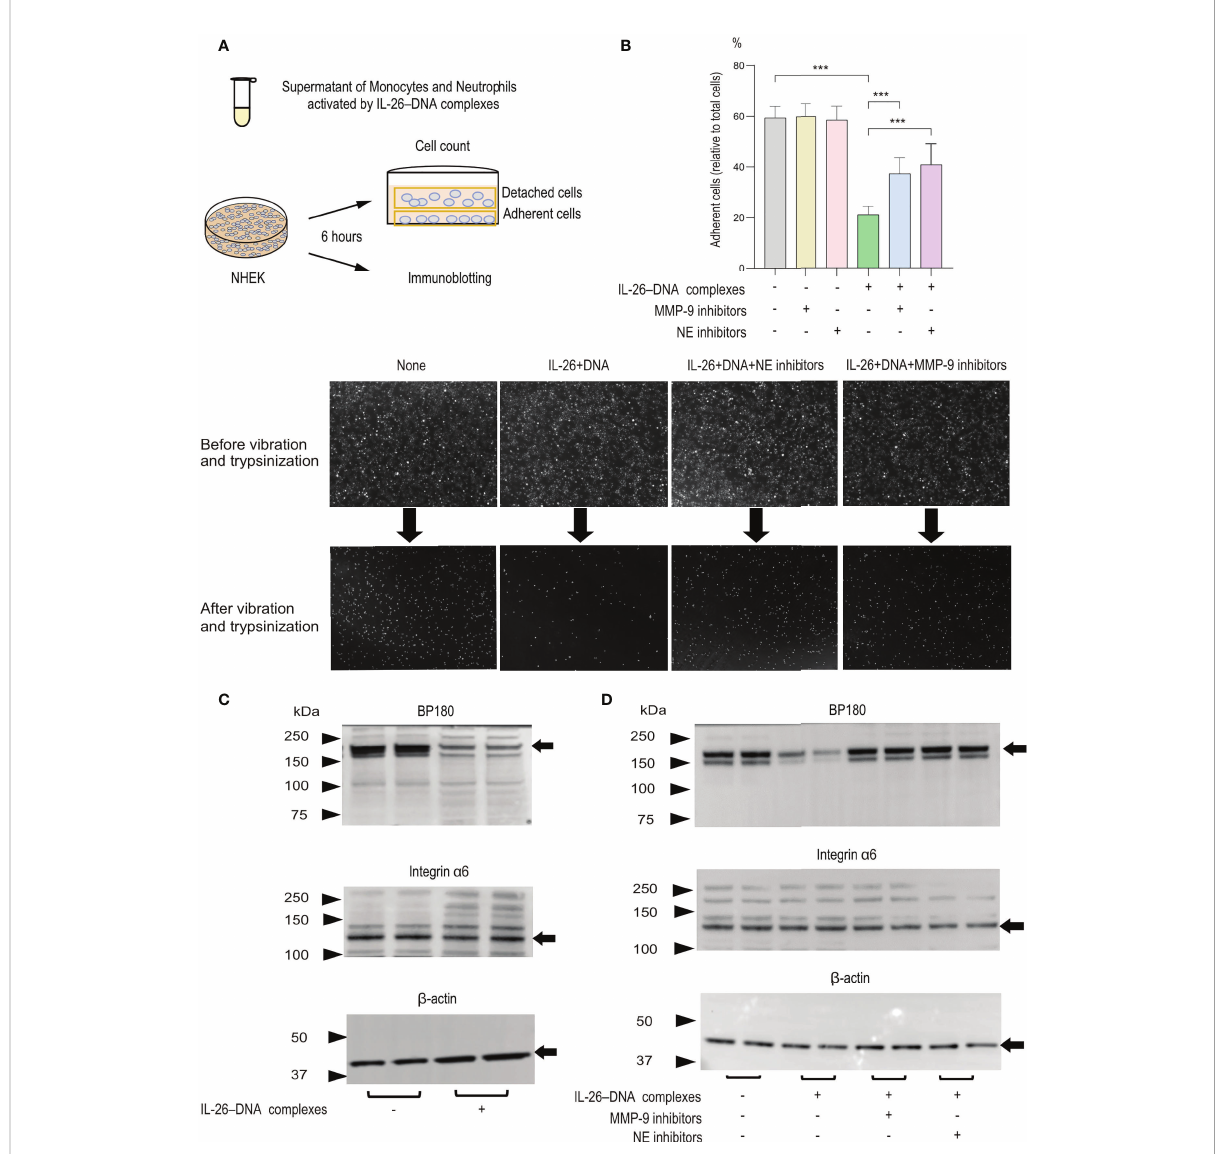
FIGURE 6 Effects of monocytes and neutrophils stimulated with IL-26 – DNA complexes on cultured NHEKs in vitro (A) Experimental design for analyzing detachment of NHEKs and cleavage of hemidesmosomal protein BP180. (B) The detachment degree of NHEKs from culture plates was assessed after 6 hours of incubation with medium including the supernatants from monocytes and neutrophils treated with vehicle or IL-26 – DNA complexes. MMP-9 or NE inhibitors were pre-administered in both conditions. The ratio of the adherent cells to total cells (adherent cells + fl oating cells) in each condition was calculated. Results shown are representative of three independent experiments with similar results. Data are presented as mean ± SD. *** p < 0.0001. The images shown are NHEKs incubated with medium containing supernatants treated with vehicle or IL-26 – DNA complexes, or with medium containing supernatants treated with IL-26 – DNA complexes along with MMP-9 or NE inhibitors. The supernatants were collected from co-cultured monocytes and neutrophils (C, D) Representative immunoblotting images of BP180, integrin a 6, and b -actin protein expression in NHEKs. Results shown are representative of three independent experiments with similar results. Black arrows indicate the bands for BP180, integrin a 6 and b -actin. Molecular weight (MW) is indicated as black triangles on the left sides. Cell lysates of NHEKs incubated with medium containing supernatants of monocytes and neutrophils were subjected to immunoblotting analysis. Monocytes and neutrophils were treated with vehicle or IL-26 – DNA complexes (C) or were pre-administered MMP-9 or NE inhibitors before treatment with complexes (D)